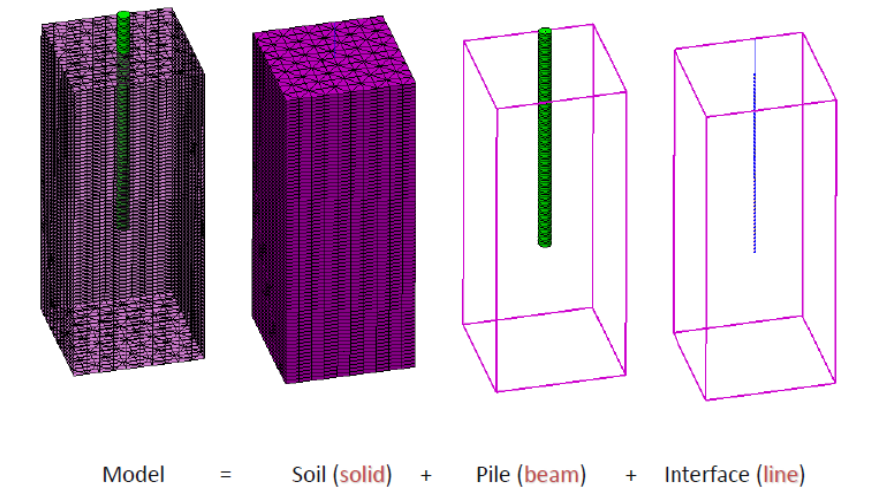
Fig. 5. Shcematic of 3D model of the pile with beam- solid connectivity elements[20].